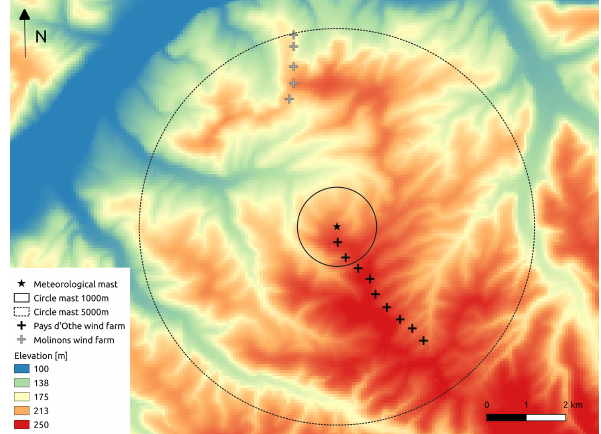
Figure 4. Elevation map around the Pay d’Othe wind farm. For the elevation in metres, the IGN DBALTI 75M product is used.